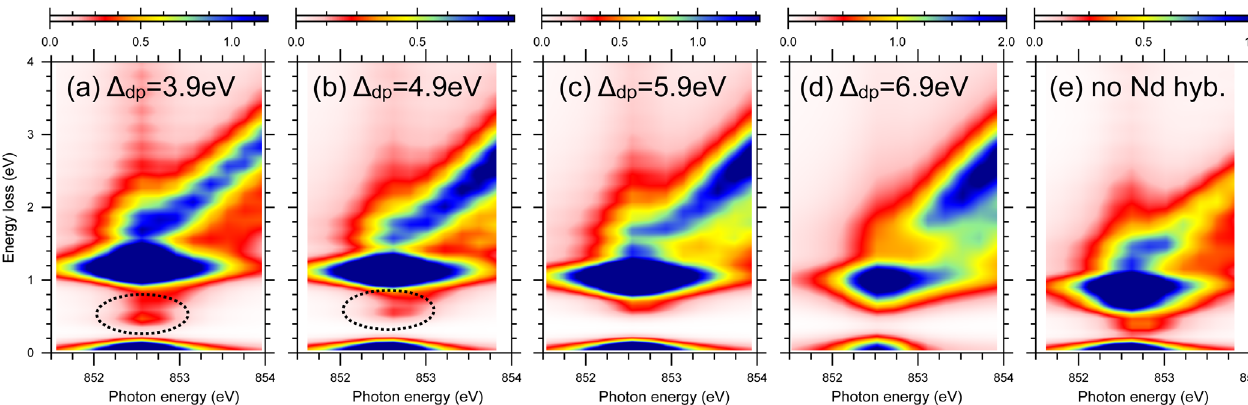
3 . 9 eV, (b) Δ 4 . 9 eV, (c) Δ 5 . 9 eV, and dp ¼ dp ¼ dp ¼ 5 d and the NiO 2